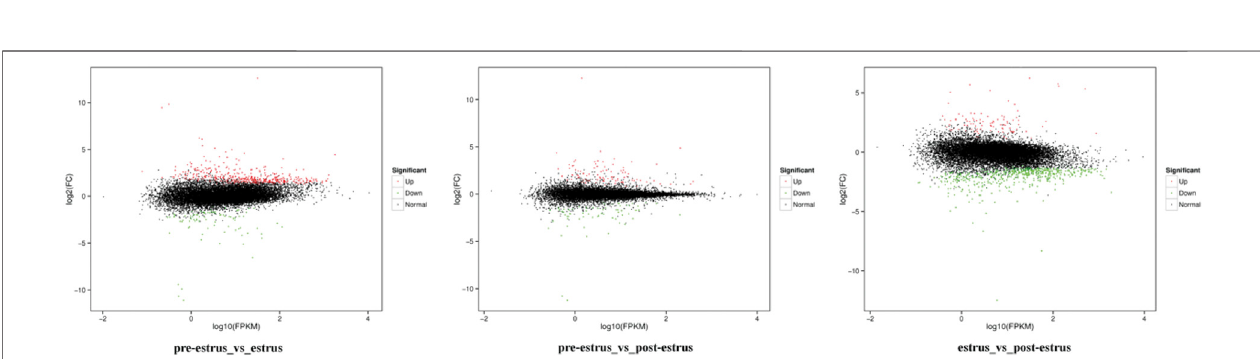
FIGURE 5 | Expression pro fi les of the identi fi ed DEGs. Red and green points represent signi fi cant DEGs with p -value ≤ 0.05, and fold change ≥ 1.5, and black points represent those without signi fi cance.